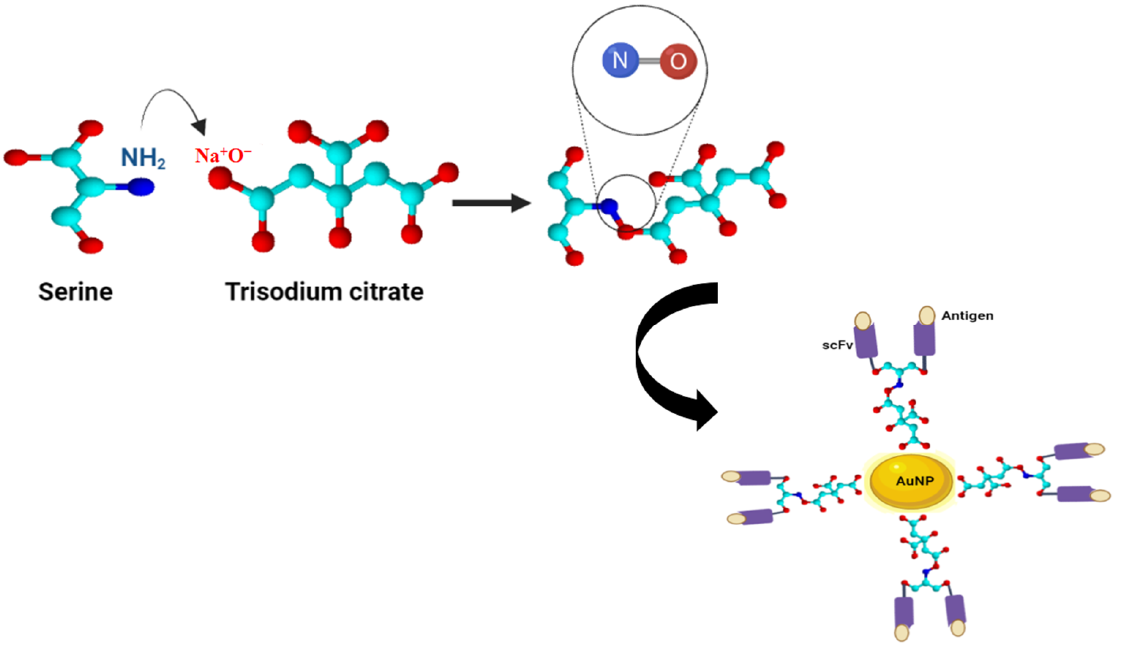
Figure 7. Schematic of the binding of serine amino acid to citrate and final situation of product on the gold nanoparticle surface.